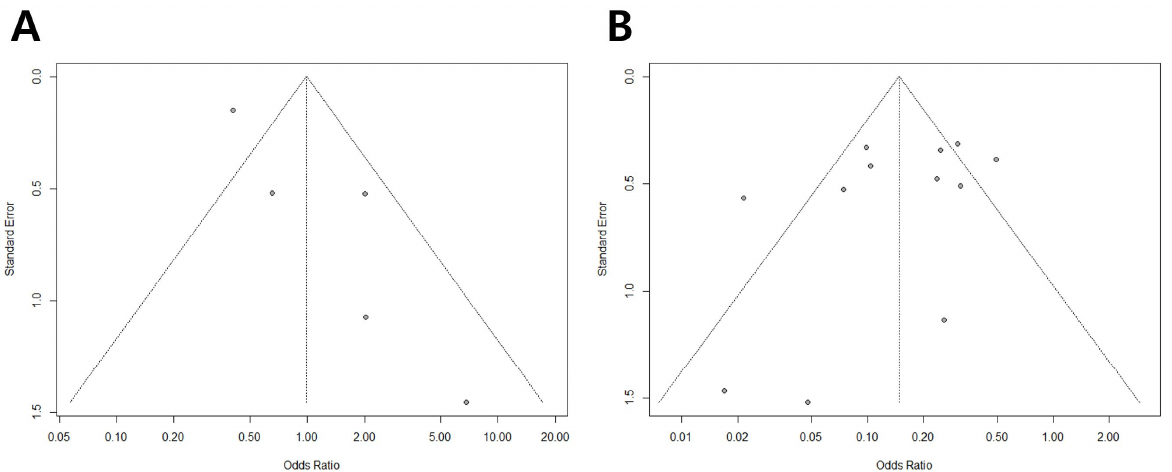
Figure 2. Funnel plots of 5-year overall survival (OS) ( A ) and 5-year recurrence-free survival (RFS) ( B ). Some publication bias was noted in the funnel plots.